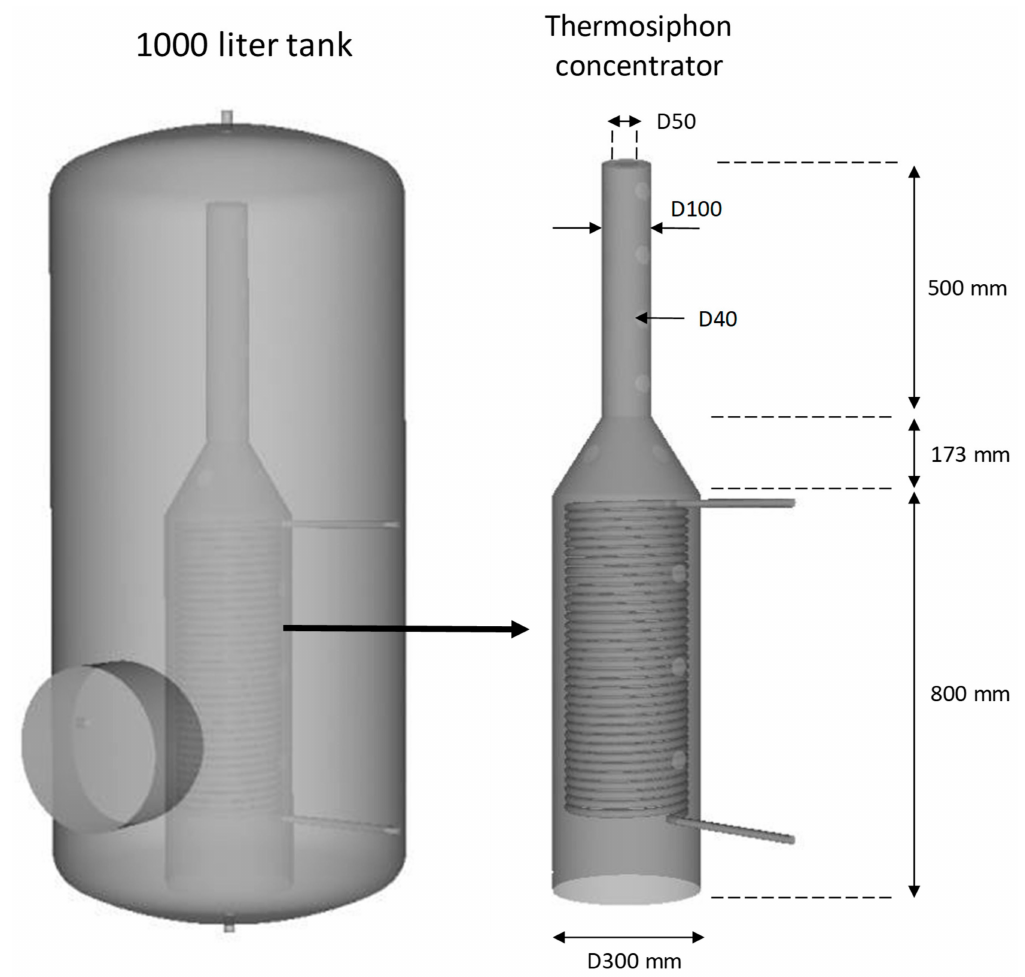
Figure 6. Bu ff er tank